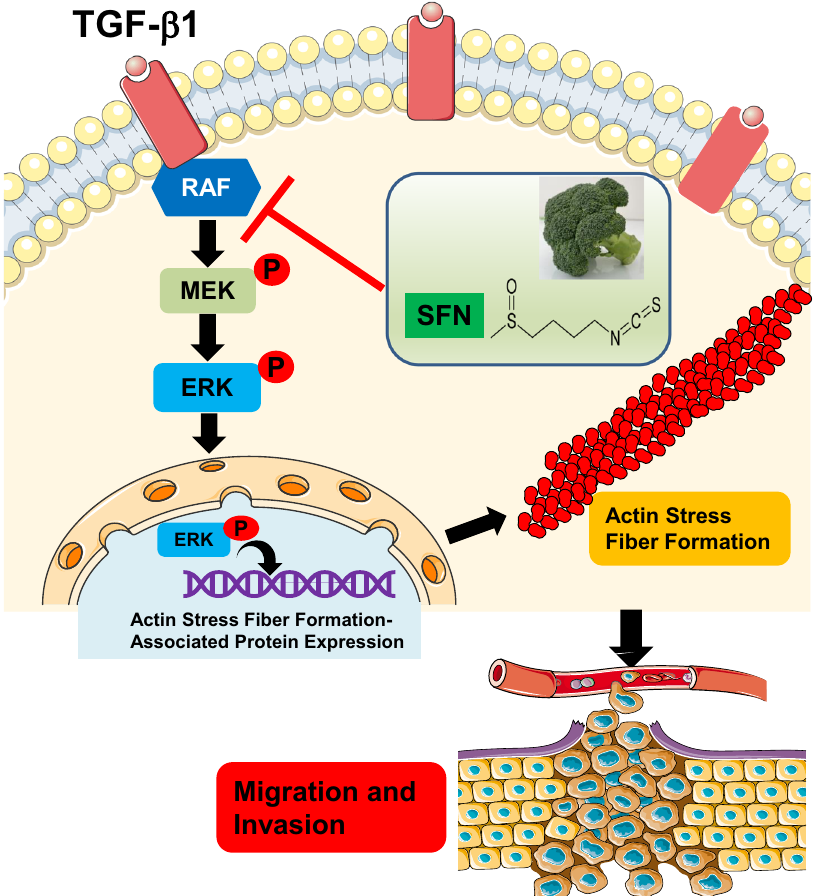
Fig. 9 A schematic diagram showing SFN suppresses migration and invasion of breast cancer by targeting the TGF- β 1-induced RAF/MEK/ ERK pathway to reduce actin stress fi ber formation. The illustrations such as receptors, plasma membrane, and cell migration and invasion were obtained from Smart Servier Medical Art